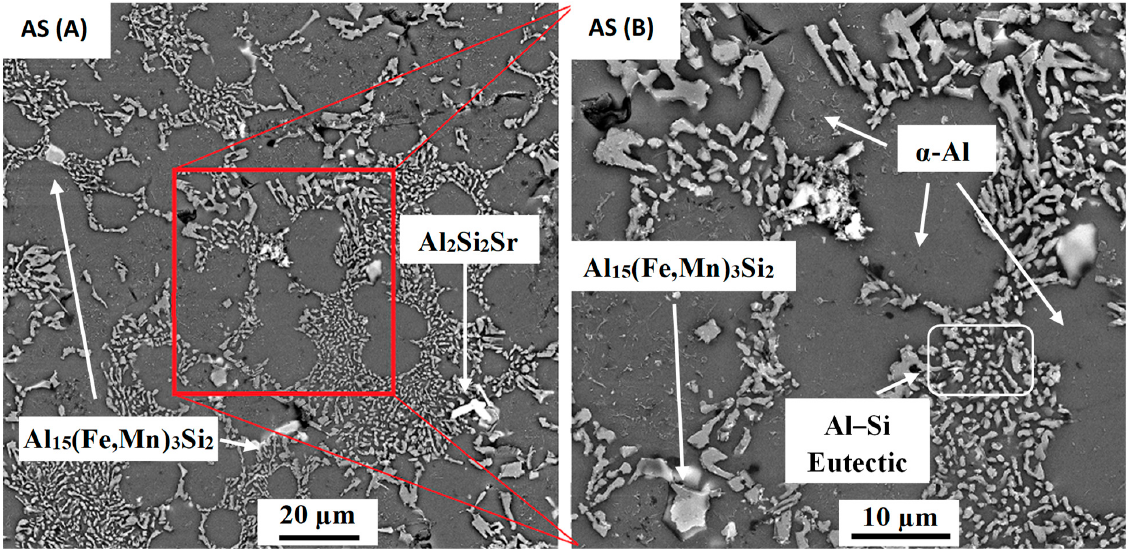
Figure 4. Representative micrographs for the as-cast component: ( A ) AS location; ( B ) close-up image of the red box region in ( A ) showing various phases.